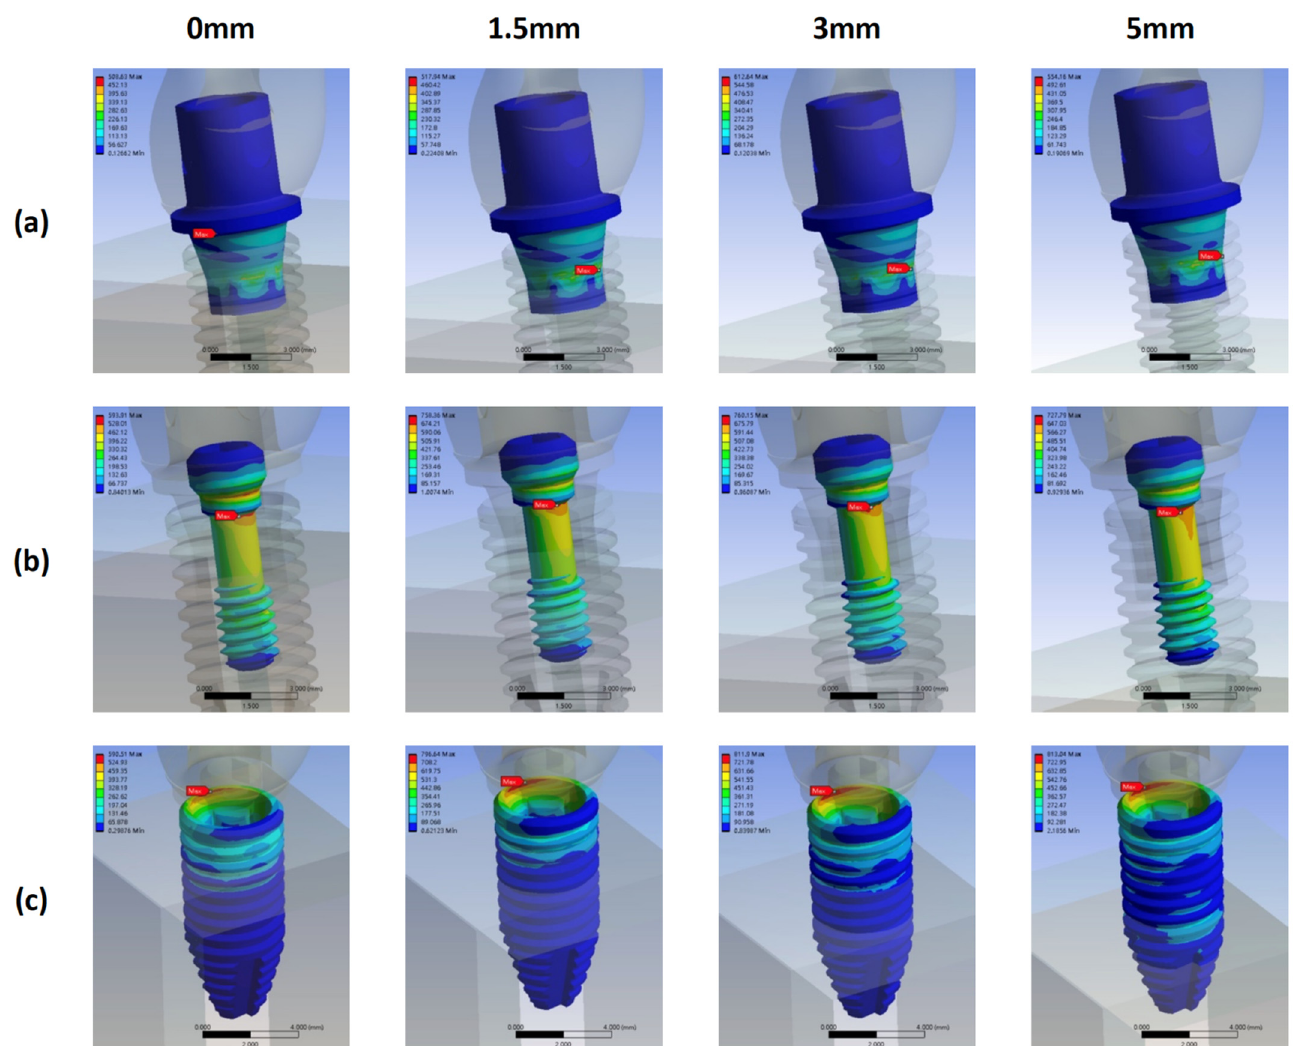
Figure 15. Stress distribution and maximum von Mises stress on the abutments, screws, and fixtures in the CZ groups with different bone loss levels. ( a ) abutment ( b ) screw ( c ) fixture.